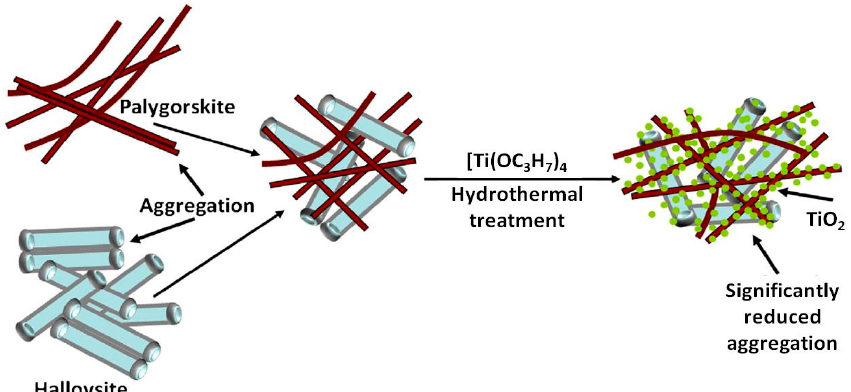
Figure 15. Schematic representation of the hydrothermal synthesis of three-phase nanocomposites with two nanoclays, showing the reduced aggregation of clay mineral particles in the three-phase system. Adapted with permission from ref. [250]. Copyight 2014